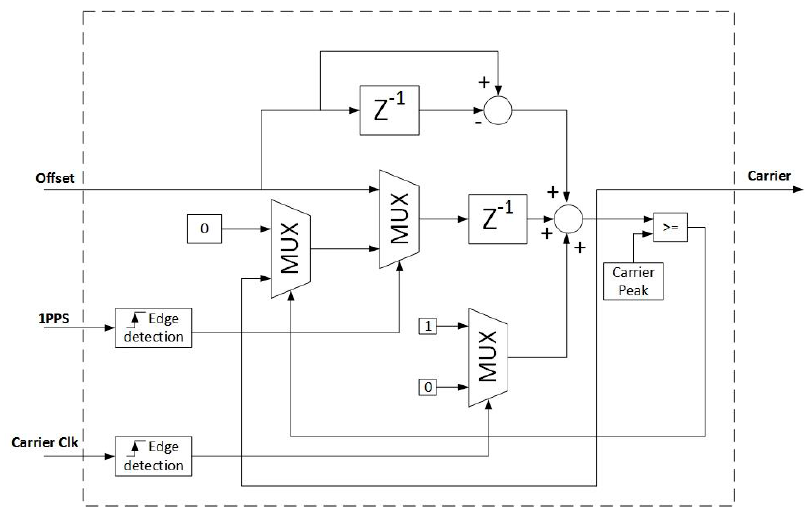
Figure 6. Carrier generation simulation model block-diagram.